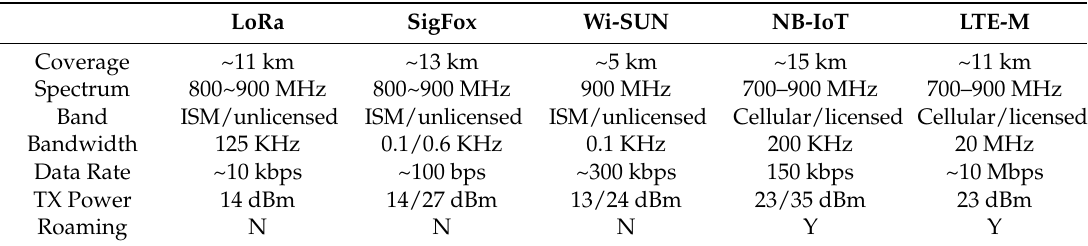
Table 1. Low Power Wide Area Radio Technologies for Internet of Things (IoT) Service. LoRa SigFox Wi-SUN NB-IoT LTE-M Coverage ~11 km ~13 km ~5 km ~15 km ~11 km Spectrum 800~900 MHz 800~900 MHz 900 MHz 700–900 MHz 700–900 MHz Band ISM/unlicensed ISM/unlicensed ISM/unlicensed Cellular/licensed Cellular/licensed Bandwidth 125 KHz 0.1/0.6 KHz 0.1 KHz 200 KHz 20 MHz Data Rate ~10 kbps ~100 bps ~300 kbps 150 kbps ~10 Mbps TX Power 14 dBm 14/27 dBm 13/24 dBm 23/35 dBm 23 dBm Roaming N N N Y